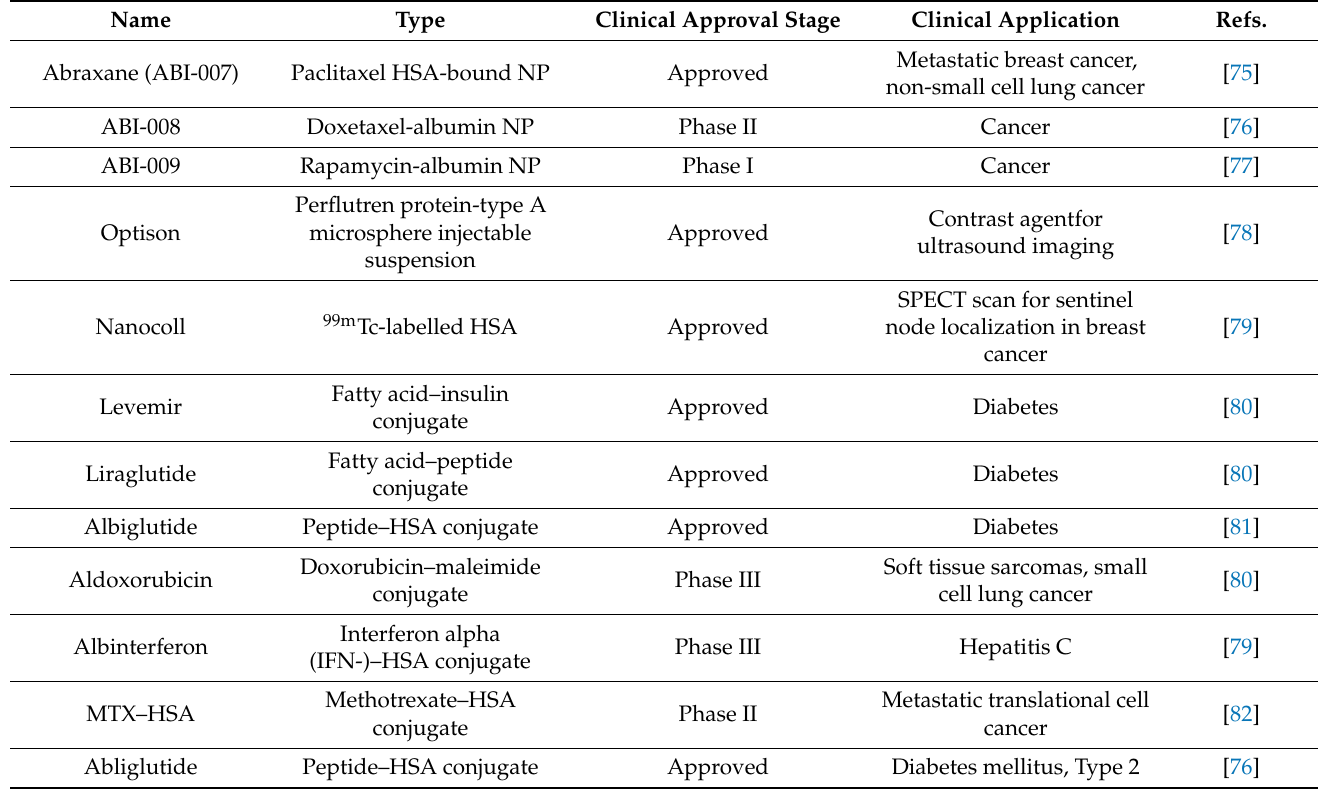
Table 1. A summary of clinically approved albumin-related